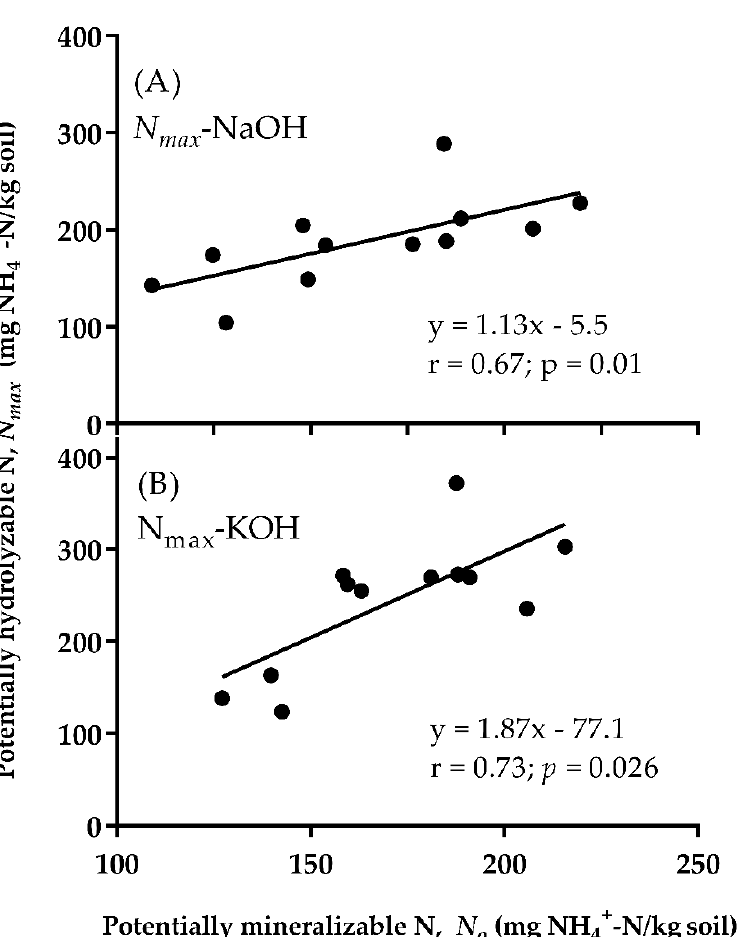
Figure 3. Relationship between potentially mineralizable N and potentially hydrolyzable N using, ( A ) 1 M NaOH, and ( B ) 1 M KOH.